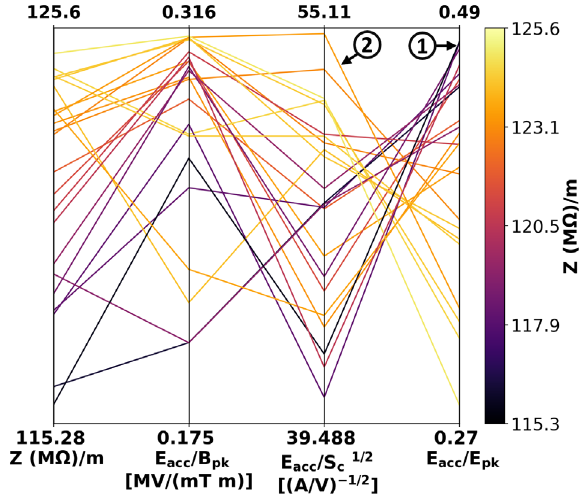
FIG. 24. 2D clustered scattered points with DM overlaid for the SW cavity to enable solution selection. Dashed lines show FIG. 25. TW cavity objective space with four objectives =E < 4 . 5 is imposed. regions of interest if a limit of E showing 24 clusters. Clusters 1 and 2 are the selected clusters pk acc Circles show selected solutions based on other objective values. for opening and picking a